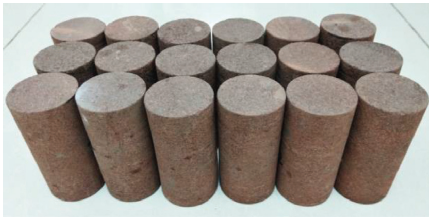
Figure 1: Red sandstone specimens. Table 1: Average physical and mechanical parameters of red sandstone.